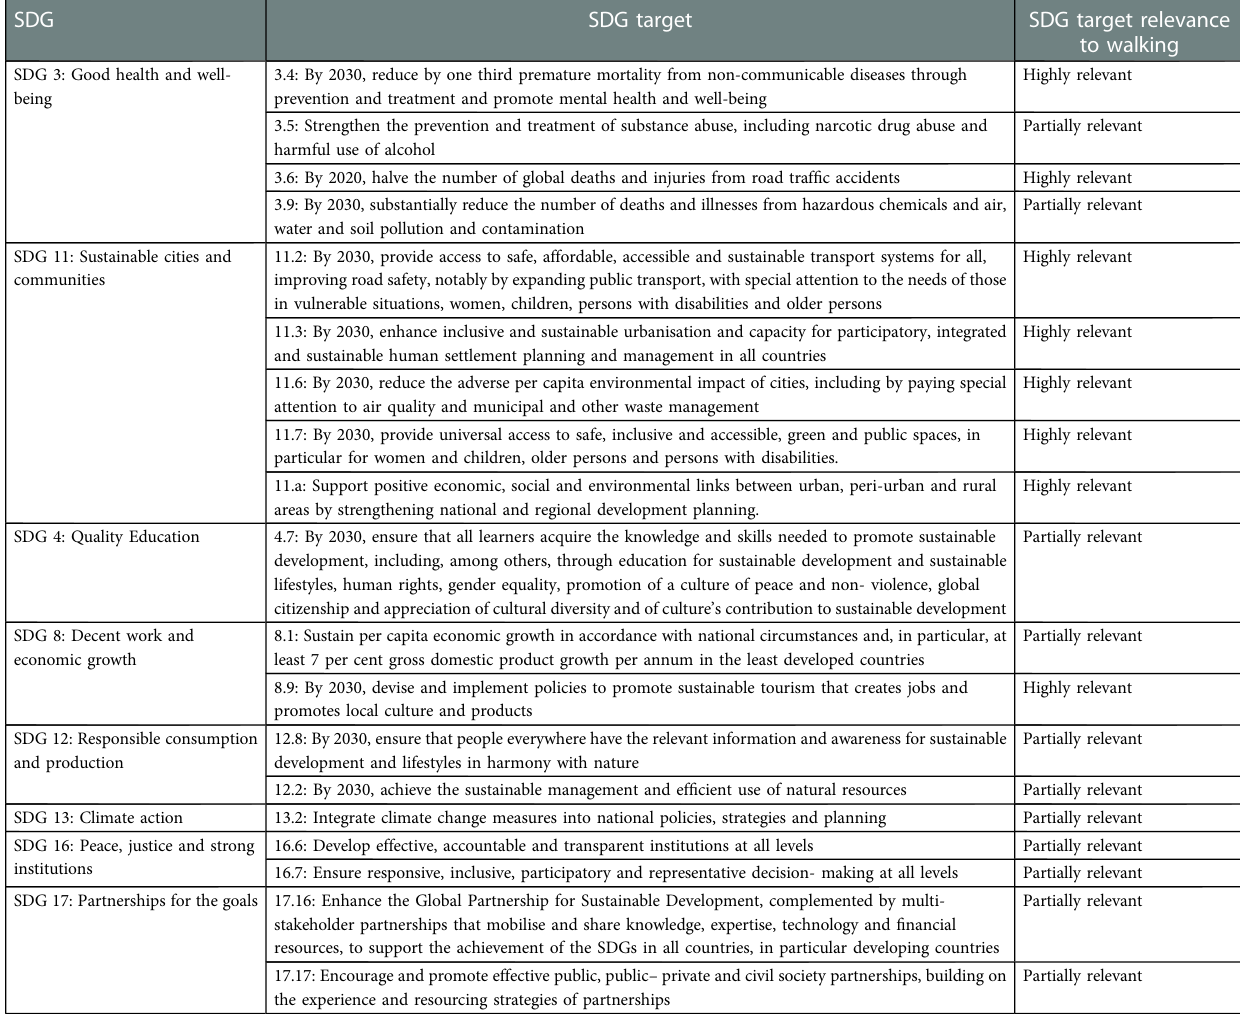
TABLE 3 Sustainable development goals and associated SDG targets identi fi ed as relevant to walking.